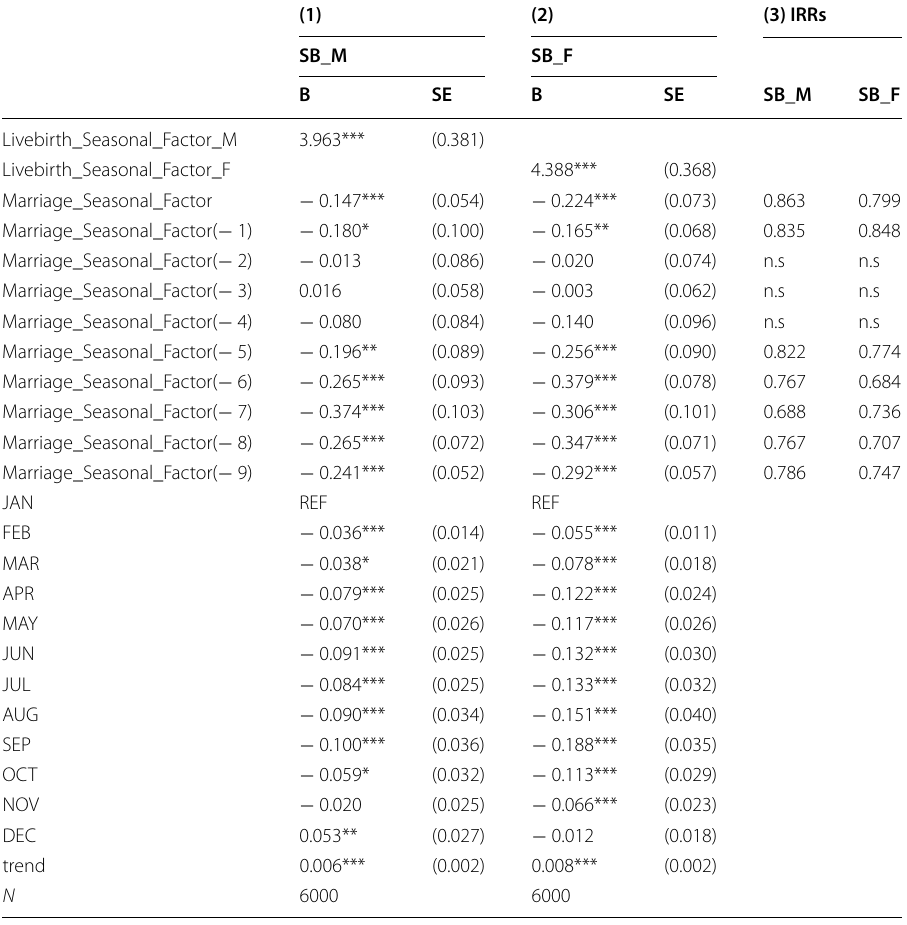
Auto-correlation robust standard errors in parentheses (Wooldridge, 1999) n.s. not